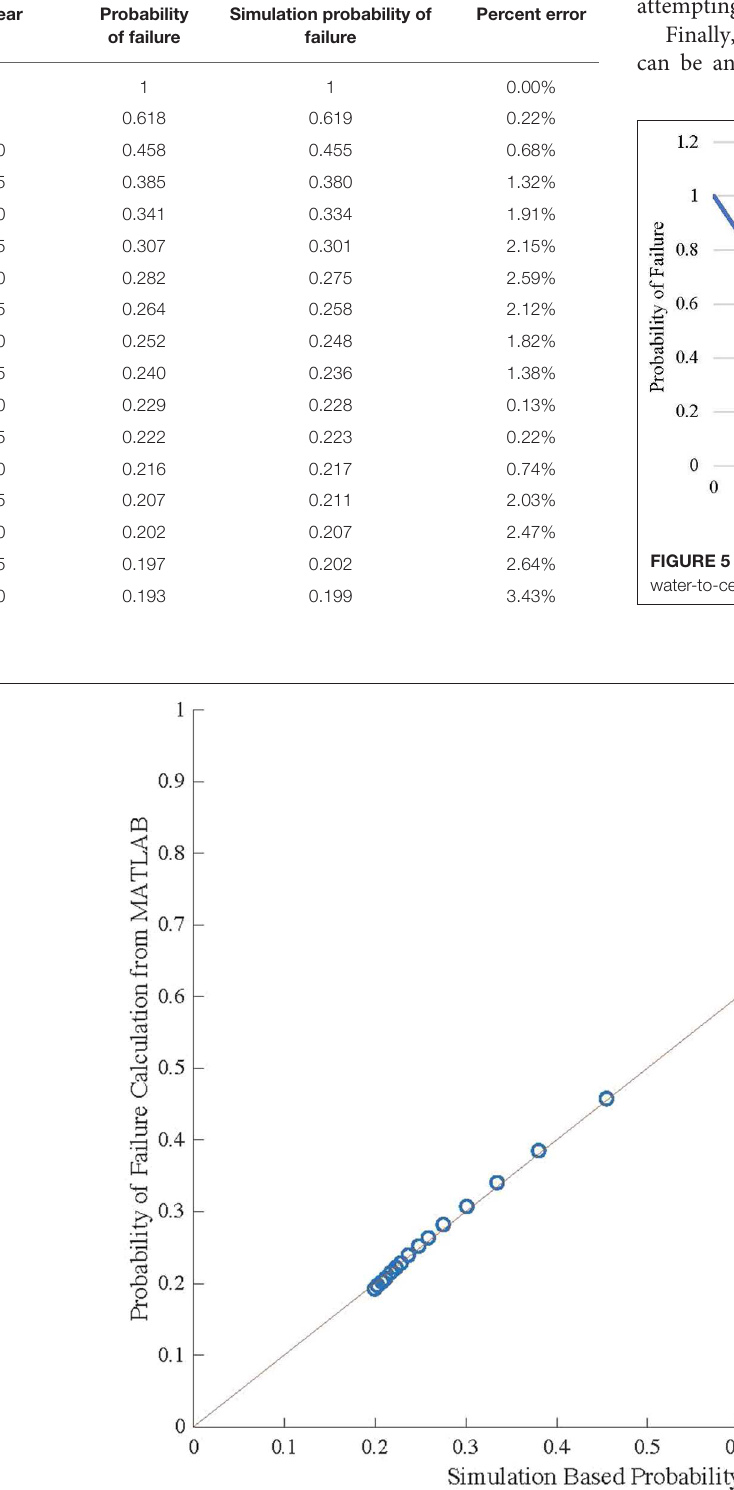
Frontiers in Built Environment |